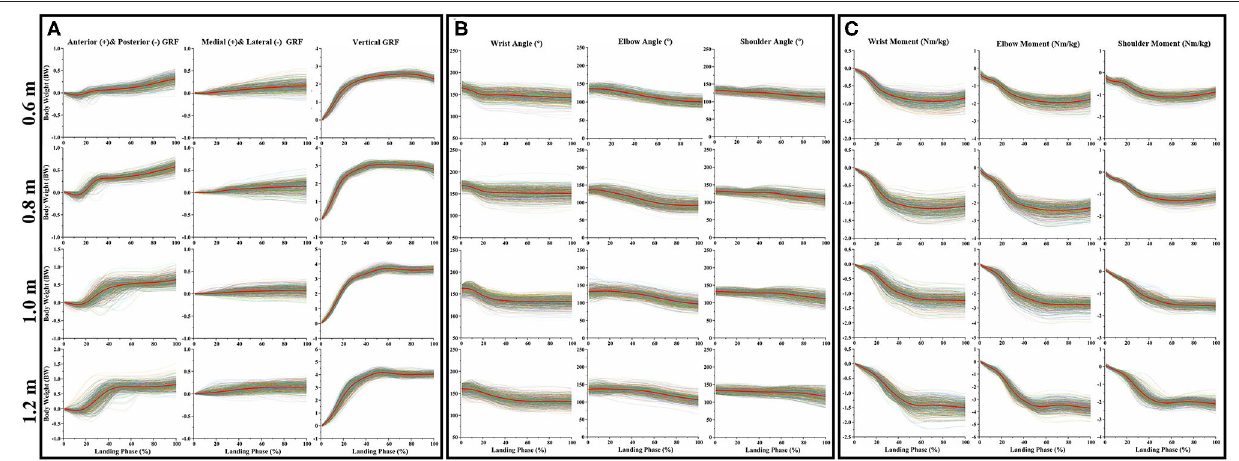
FIGURE 3 | The data waveform curves of GRF, joint angle, and joint moment. (A) Illustrates the changes in GRF in three directions (anterior and posterior, medial and lateral, and vertical) during the cat landing phase from different heights. (B) Illustrates the changes of three joint angles (wrist, elbow, and shoulder) during the cat landing phase from different heights. (C) Illustrates the changes of three joint moments (wrist, elbow, and shoulder) during the cat landing phase from different heights. The colored data of each image represented 560 data sets recorded during the cat landing phase from different heights. The red line data of each image represents the average value of 560 data sets during the cat landing phase from different heights. On the left of each image, the scale displays the change of GRF/ angle/moment values. Zero to one hundred below each image presents a landing